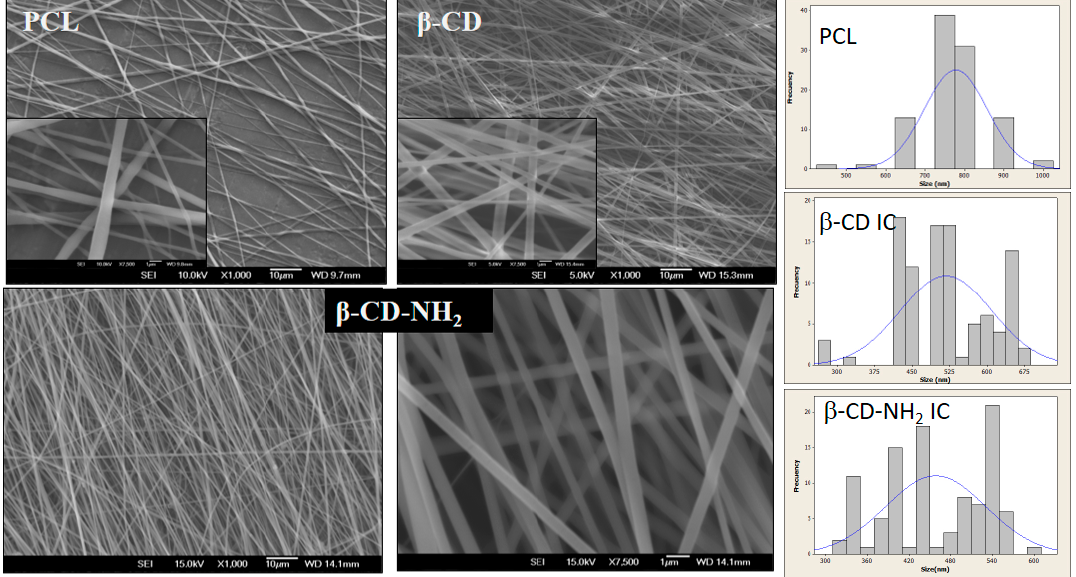
Figure 11. SEM Images of PCL and IC nanofibers scaffolds from 12 wt % IC /TFE (2,2,2- trifluoroethanol), 0.8 mL/h, 8 kV, 18 cm and 2000 rpm of the collector rotation rate. PCL and β -CD IC nanofibers; β -CD-NH 2 IC nanofibers (1000 × and 7500 × ) obtained in the same conditions.